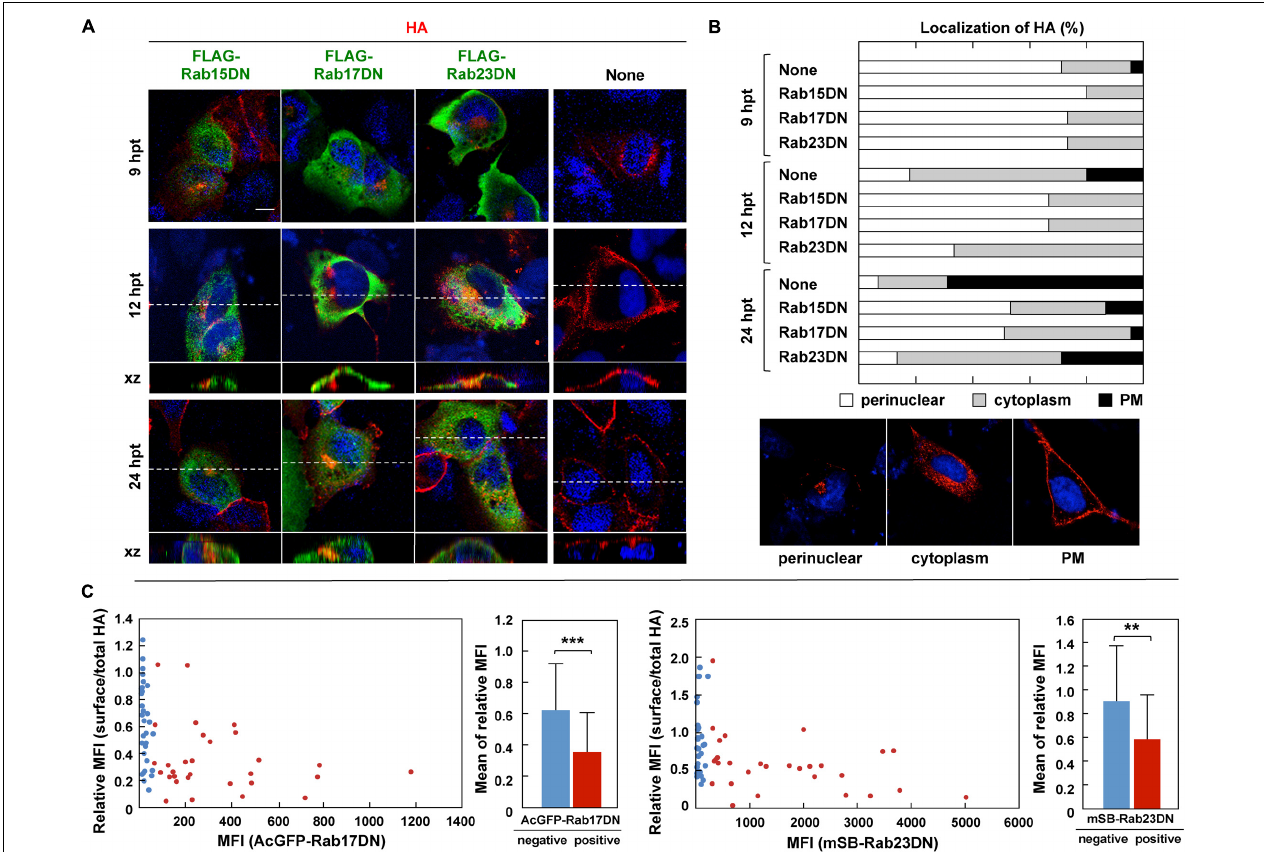
FIGURE 6 | Aberrant localization of HA by coexpression with RabDN mutants. (A) Intracellular localization of HA in RabDN-expressing cells. Parental MDCK cells were transfected with expression plasmids for FLAG-tagged DN mutants of Rab15, Rab17, and Rab23. After 12 hpt, cells were transfected with an HA expression plasmid and were cultured for another 9, 12, and 24 h. At each time point, the cells were stained with anti-HA mAb (red) and anti-FLAG mAb (green). Confocal images in the xy planes were shown. Dashed lines in xy images indicate the positions of xz images. All images were taken at the same magnification. Scale bar, 10 µ m. (B) For quantification of the HA localization, 50 antigen double-positive cells were subjected to HA distribution pattern analysis. Representative patterns of intracellular HA localization (perinuclear, cytoplasmic, and PM) were shown. (C) Cell surface expression of HA. Parental MDCK cells were transfected with expression plasmids for AcGFP-Rab17DN and mSB-Rab23DN mutants. After 12 hpt, cells were transfected with an HA expression plasmid and were cultured for 24 h. The cells were fixed without permeabilization and were incubated with mouse anti-HA mAb (for surface HA). After membrane permeabilization, the cells were stained with rabbit anti-HA Ab (for total HA). Confocal images were collected at 0.5 µ m intervals in z-direction. In each acquired channel, the sum of fluorescence intensity values of a z-stack was calculated as a z-projection image by using ImageJ software. Single cells were selected as region of interest (ROI), and the MFI in each channel was measured. Approximately 50 cells were subjected to the calculation of the relative MFI of cell surface HA to total HA. In individual cells, the relative MFI of HA was plotted against the MFl of AcGFP-Rab17DN or mSB-Rab23DN. The cells expressing < 5% of the maximum value of AcGFP/mSB MFI were considered as negative for Rab17DN/Rab23DN expression. The relative MFIs of HA were sorted into Rab17DN/Rab23DN-positive and negative groups and statistical analysis was performed with t -test. ∗∗ P < 0.01; ∗∗∗ P <